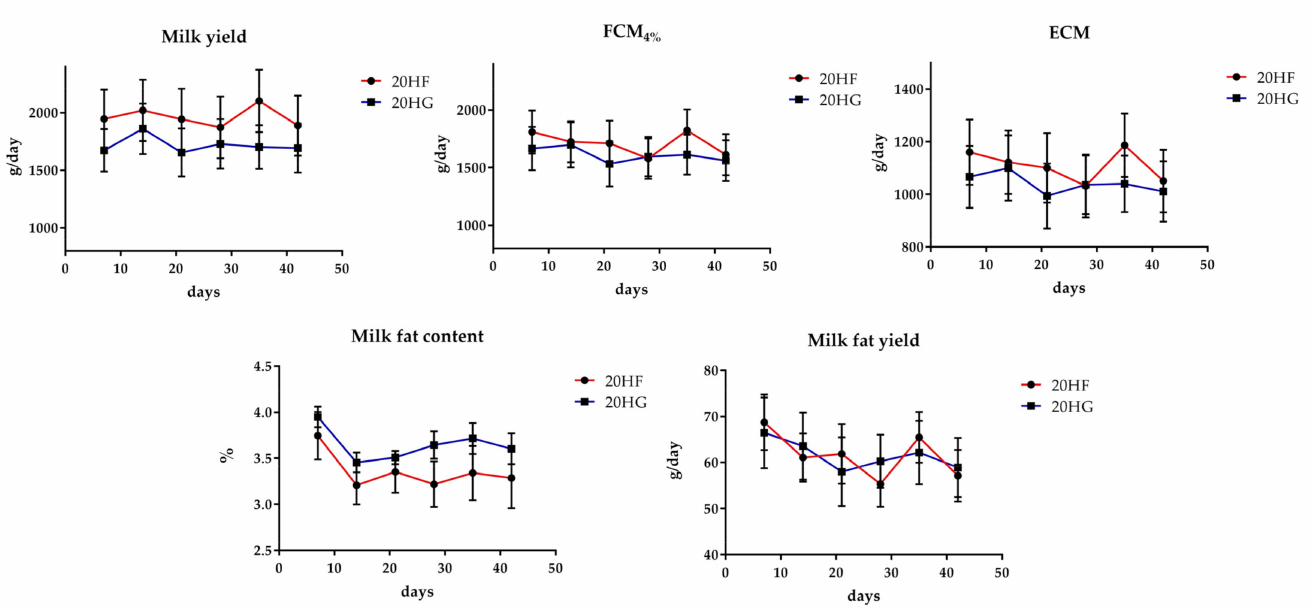
Figure 1. Mean milk performance of goats fed diets with 20 g Schizochytrium spp. and two different forage to concentrate ratios (20 HF; red line and 20 HG; blue line) throughout the experimental period. Error bars represent the standard error of the means (SEM). 20 HF: 20 g Schizochytrium spp. and high forage diet (60:40); 20 HG: 20 g Schizochytrium spp. and high grain diet